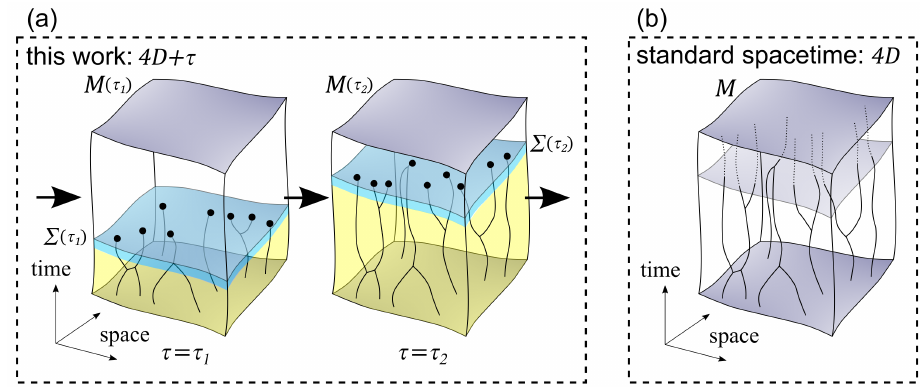
Figure 1. ( a ) Schematic illustration of the 4+1 formalism (only two spatial dimensions are shown). At each value of the evolution parameter τ , there is a corresponding 4D spacetime that satisfies the Einstein field equations. The hypersurface Σ ( τ ) is associated with the present, shifting physically in the positive time dimension as τ increases. For increasing values of τ , there is a growing region (yellow) in the past of the hypersurface Σ ( τ ) that is largely crystallized into a rigid network of worldlines. In the future region (white), worldlines are not yet fully formed but this region physically exists. In the interface region (blue) near the hypersurface Σ ( τ ) , particle worldlines still have a large freedom to readjust as a function of τ , which is relevant for explaining quantum phenomena. ( b ) According to a standard observer who collects 4D measurement events, a classical spacetime emerges that is compatible with classical general